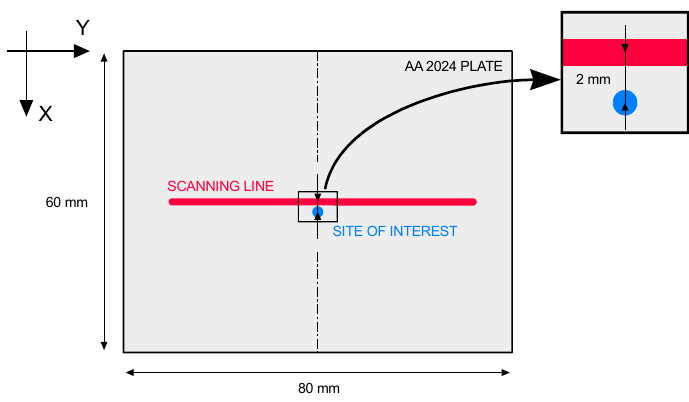
Figure 7. Location and detail of the site of interest ( x = 32 mm, y = 40 mm, z = 10 mm) for thermal monitoring.